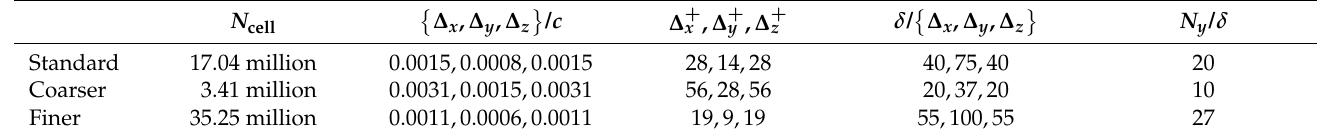
Table 4. Grid scales near the wall-mounted hump at x / c = 0.5 for NewMesh